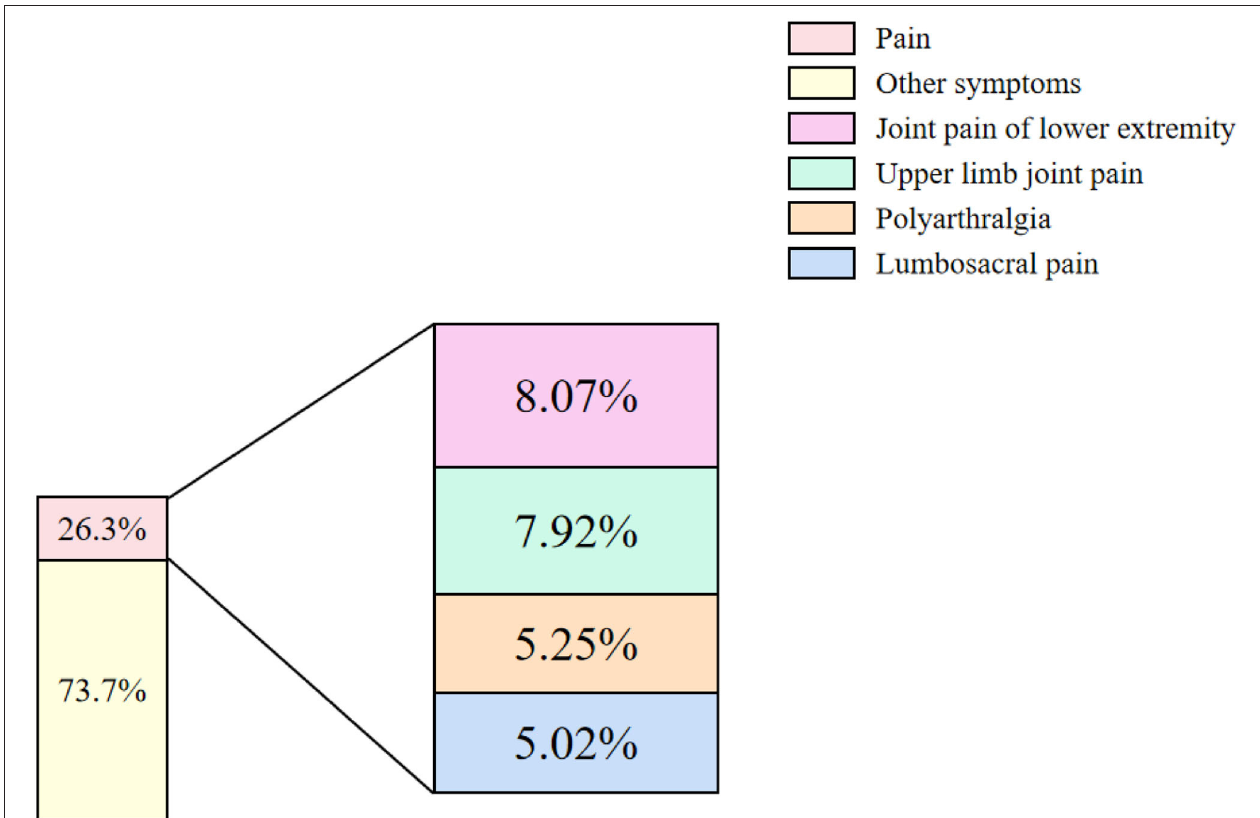
FIGURE 2 | Proportions of different pain symptoms. The proportions of symptoms from 311 cases were classified into two kinds: “pain” and “other symptoms” (On the left). The pain symptoms mainly consisted of four kinds: “Joint pain of lower extremity,” “Upper limb joint pain,” “Polyarthralgia,” and “Lumbosacral pain” (On the right). Pink: Pain; Pastel yellow: Other symptoms; Purple: Joint pain of lower extremity; Green: Upper limb joint pain; Earthy yellow: Polyarthralgia; Blue: Lumbosacral pain.